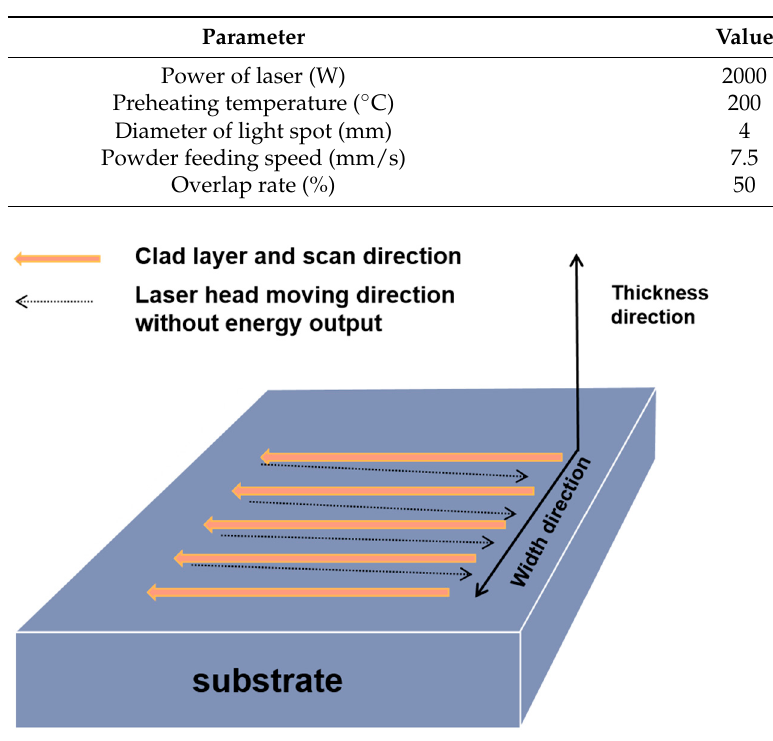
Figure 1. Laser flexible additive manufacturing system. Table 4. Selection of laser-cladding-process parameters.